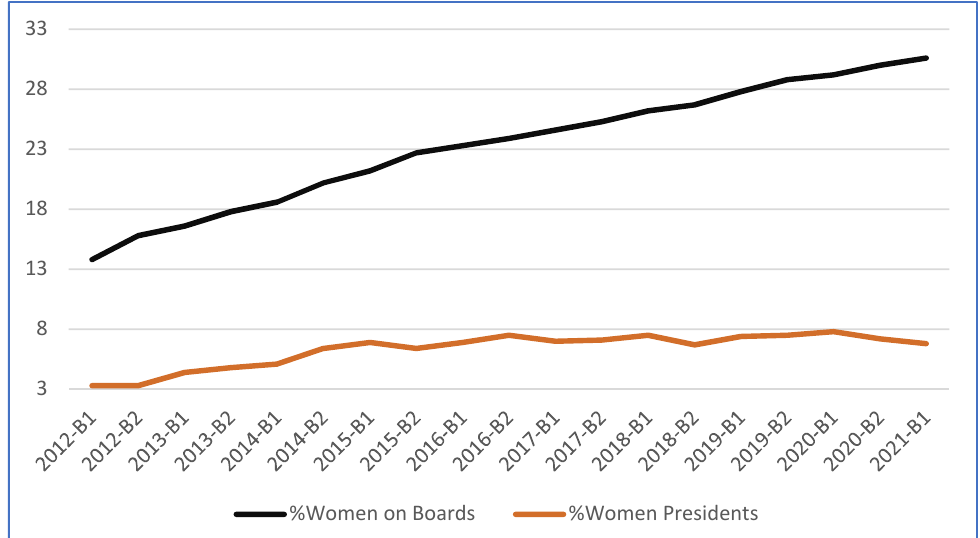
Figure 1. Percentages of women presidents and board members—EU28.